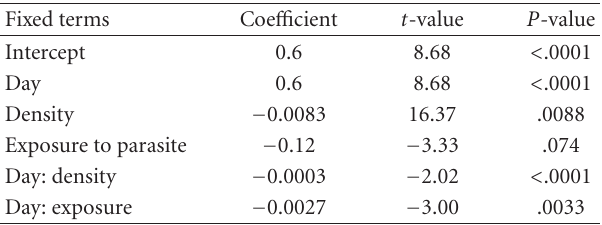
Table 1: Minimal adequate model for weight of snails containing all significant terms. Insignificant first-order terms were retained only if a second-order interaction containing that term was significant.